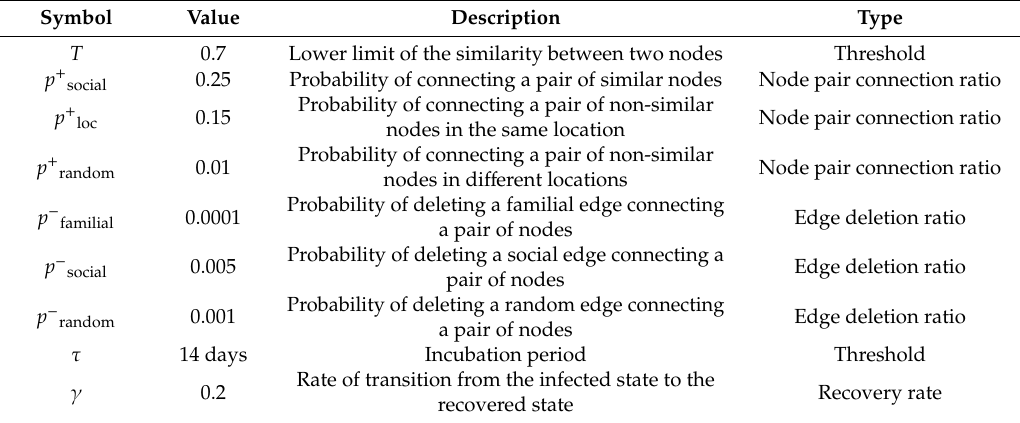
Table 3. Simulation model parameters.